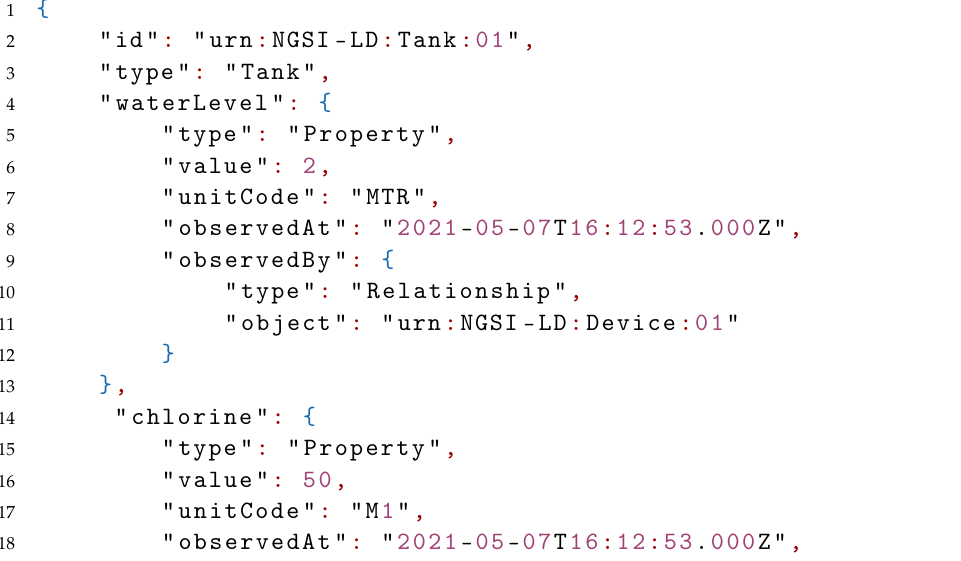
Figure 2. Tank NGSI-LD Entity Data Model. The JSON-LD serialization of the tank entity is depicted in Listing 1. Listing 1. A Json-LD serialization of Tank